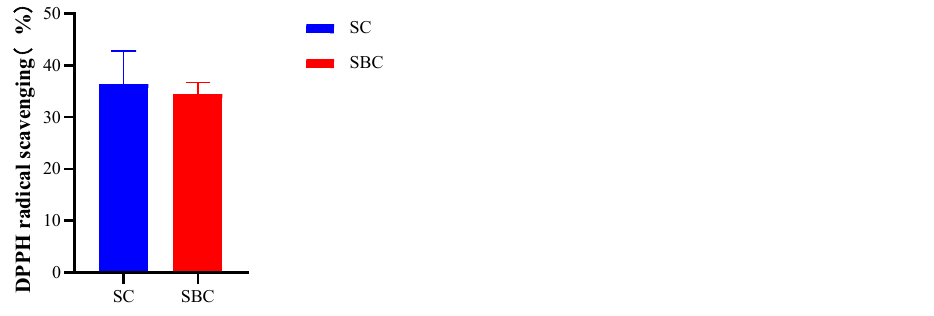
Figure 3. ( A ) CD spectra of collagen from skin (SC) and swim bladder (SBC) of C. idella and ( B ) temperature effect on the CD spectra at 221 nm of collagen from skin (SC) and swim bladder (SBC) of C. idella .